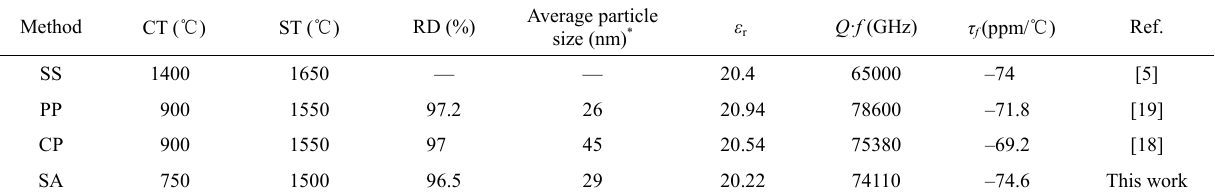
Table 2 Sintering parameters and microwave dielectric characteristics of SmAlO 3